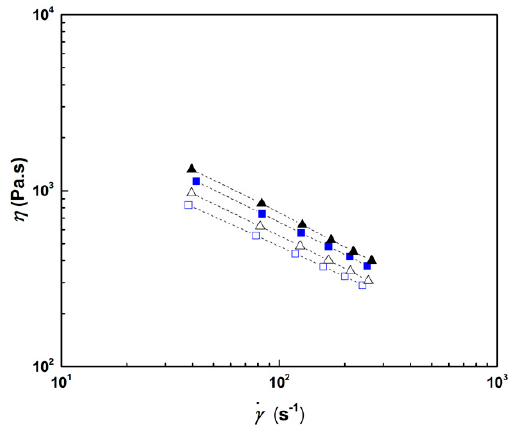
Figure 9. Flow curves measured with LDPE at 150 °C (solid symbols) and 180 °C (open symbols) using the piezoelectric (triangles) and the conventional (squares) pressure transducers.